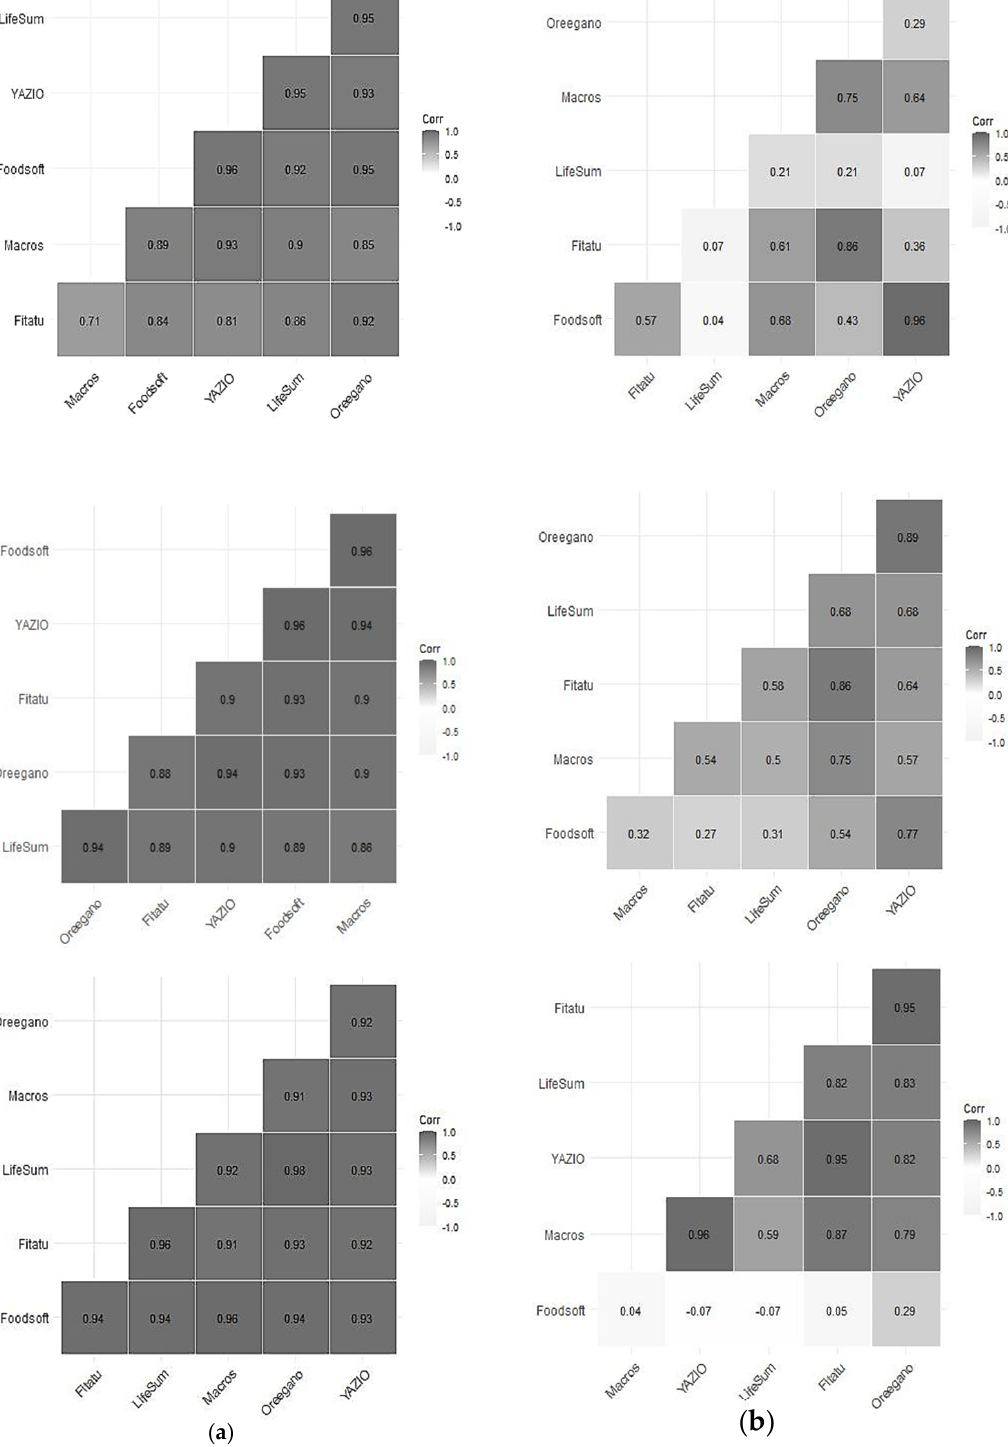
Figure 2. Spearman correlation plots for estimated intakes of carbohydrates, proteins and fats for the whole sample ( a ) and for the selected seven 24-HRs ( b ) .